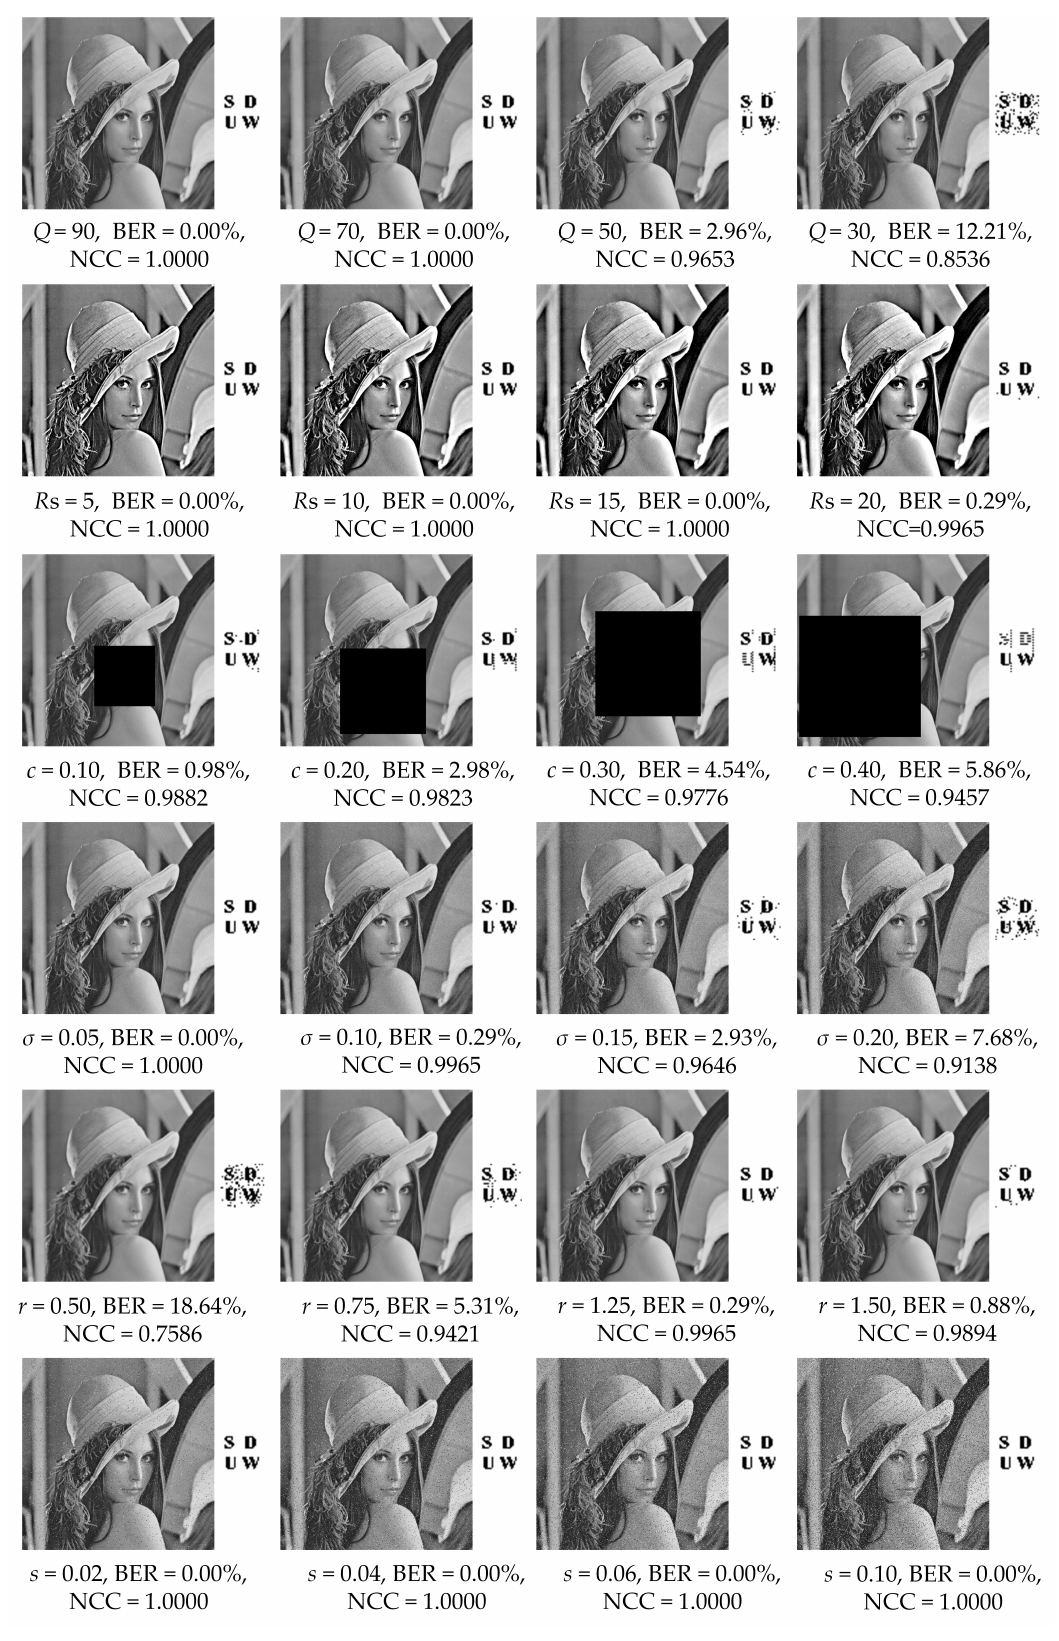
Figure 10. Visualization of attacked images and extracted